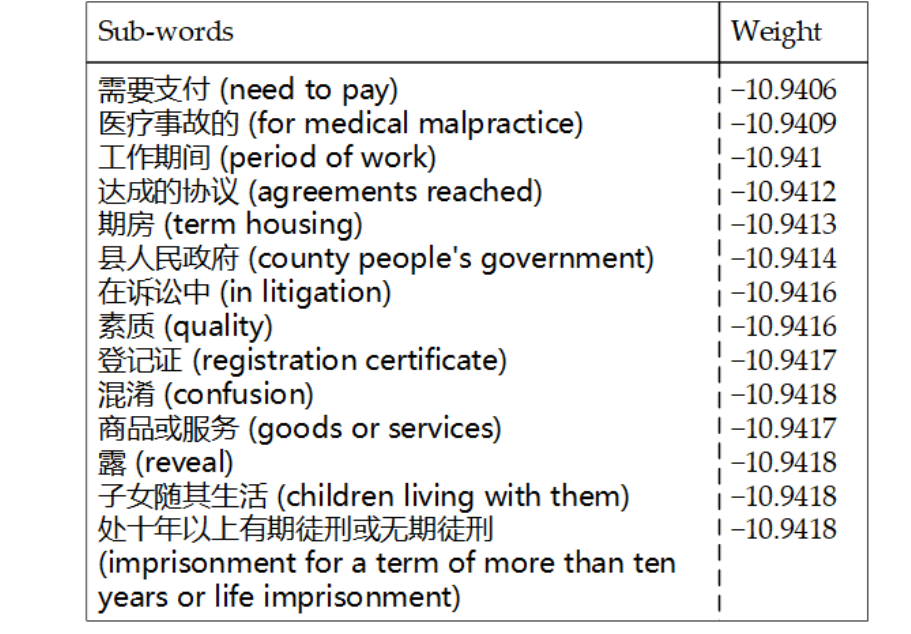
Figure 6. Word lists and weights in Chinese XLNet.